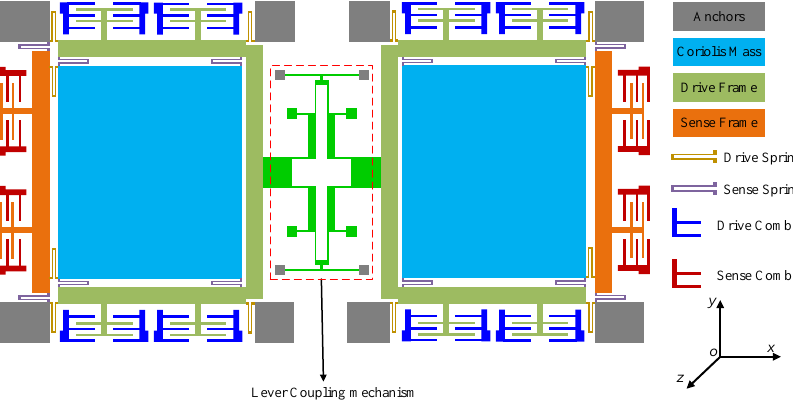
Figure 10. The silicon micro-gyroscope structure with the designed lever coupling